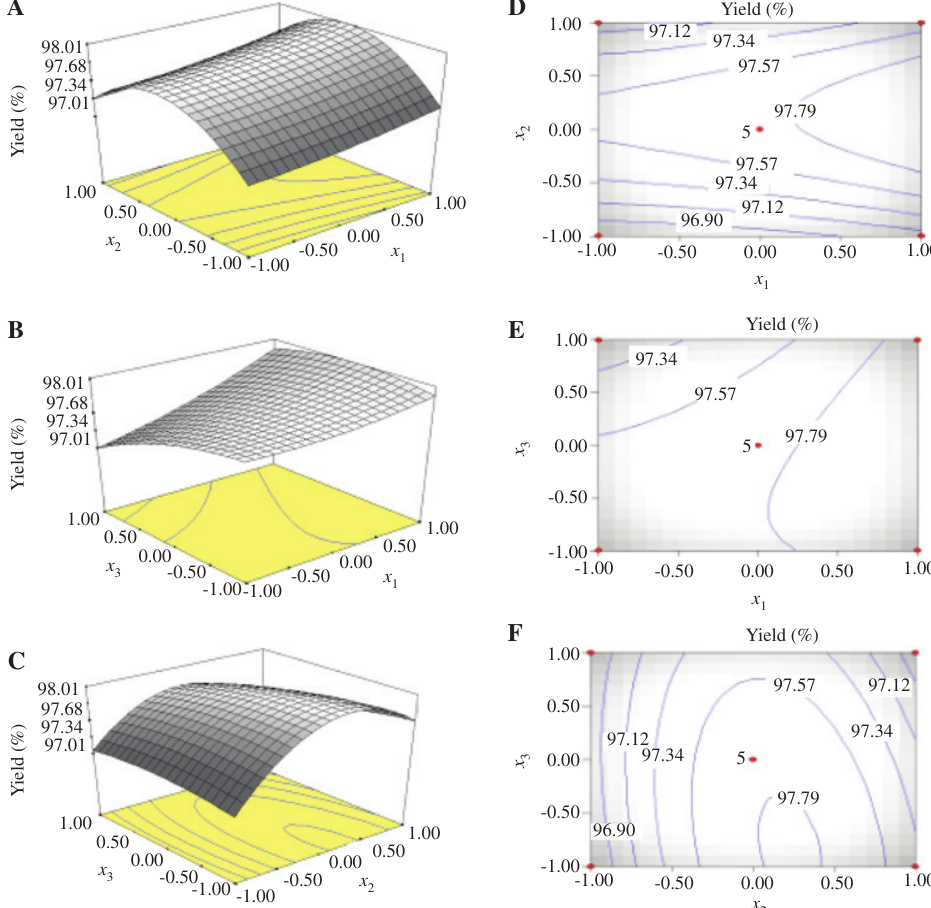
Figure 1: (A–C) 3D response surface and (D–F) contour plots showing correlations between a pair of experimental variables (Table 1) and relevant effects on predicted butyl butyrate yield while keeping other variables at a constant level of 0.